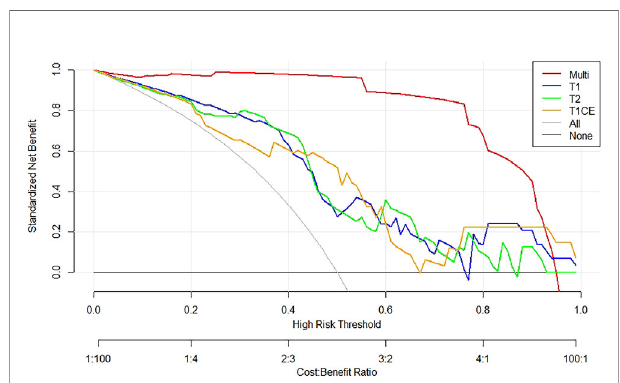
FIGURE 6 | Decision curve analysis constructed using the radiomics features extracted from T1WI, T2WI, and T1CE sequences. The y-axis measures the net bene fi t of the T1WI (blue curve), T2WI (green curve), T1CE (yellow curve), and the multiparametric (red curve) images. The gray curve represents the assumption that all patients were treated, and the straight black line at the bottom of the fi gure represents the assumption that none of the patients were